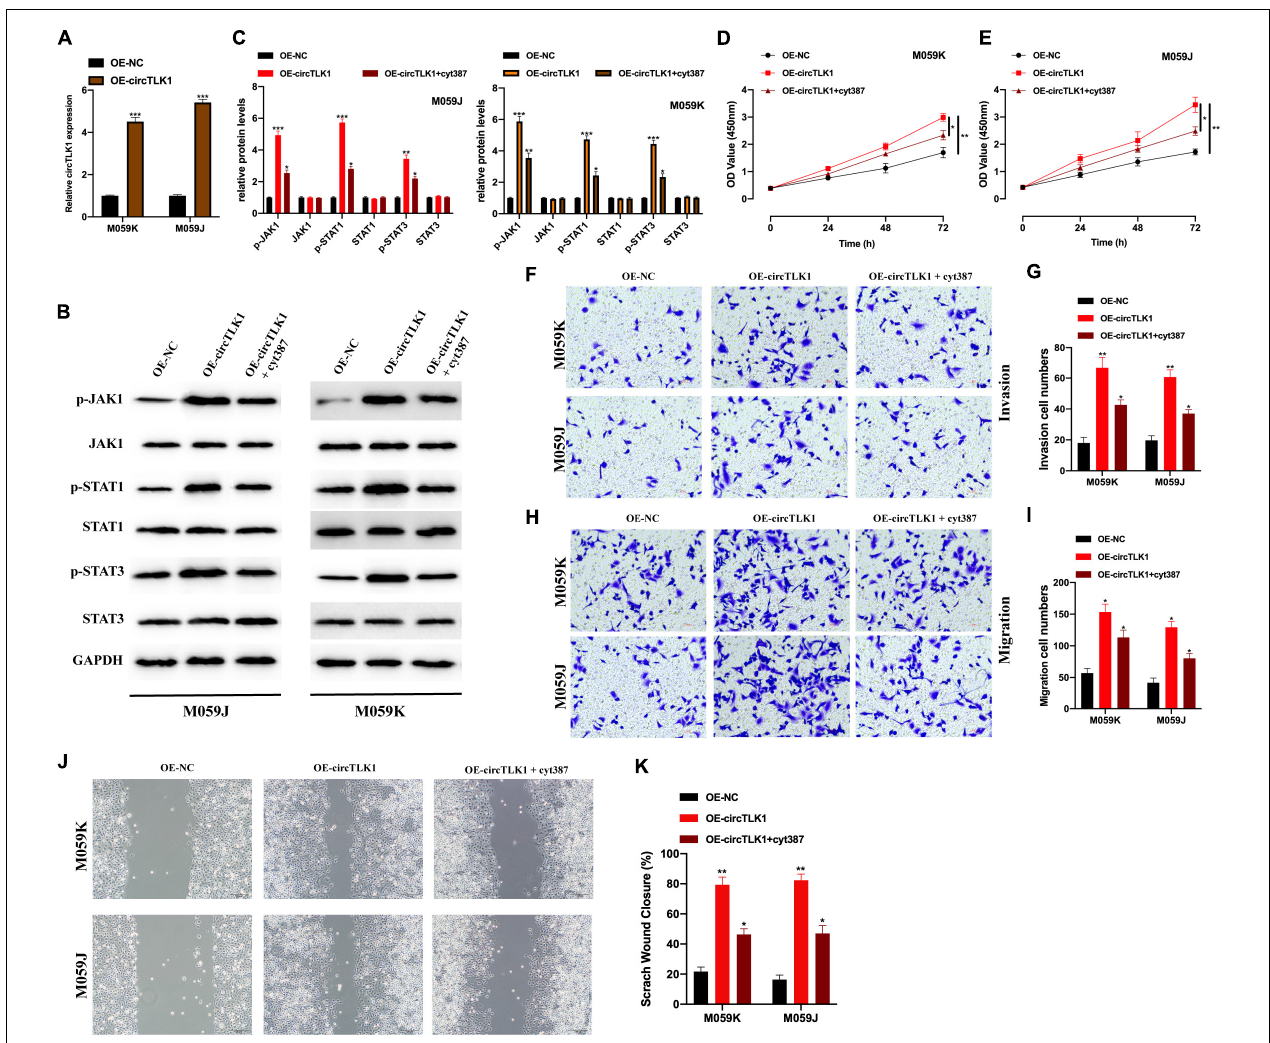
FIGURE 4 | CircTLK1 modulates gliomagenesis by activating JAK/STAT signaling. M059K and M059J cells were transfected with OE-NC or OE-circTLK1. (A) M059K and M059J cells were subjected to qRT-PCR to detect transfection efficiencies. (B,C) The expression of JAK/STAT pathway proteins in M059K and M059J cells, which were pretransfected with OE-NC, OE-circTLK1, and JAK/STAT inhibitor cyt387 as indicated, measured using Western blot, and comparative statistics are presented. (D,E) CCK-8 assays were conducted to measure the proliferation levels. (F,G) Treated M059K and M059J cells were subjected to a Transwell migration experiment to measure the cell migration level. (H,I) Transwell invasion assays were applied to detect cell invasion levels of treated M059K and M059J cells. (J,K) Scratch test was applied to evaluate the migration ability of transfected cells. *p < 0.05, **p < 0.01, ***p <